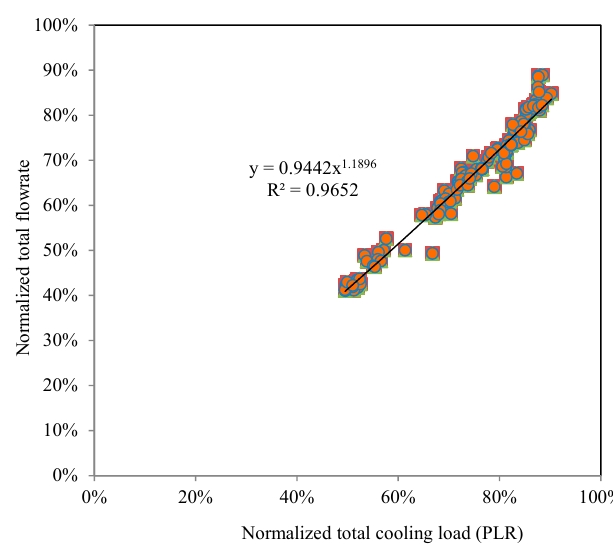
Figure 5. Parameter identification of AHU using operational data of three days. Table 1. Monitored operational data from BMS for case study.